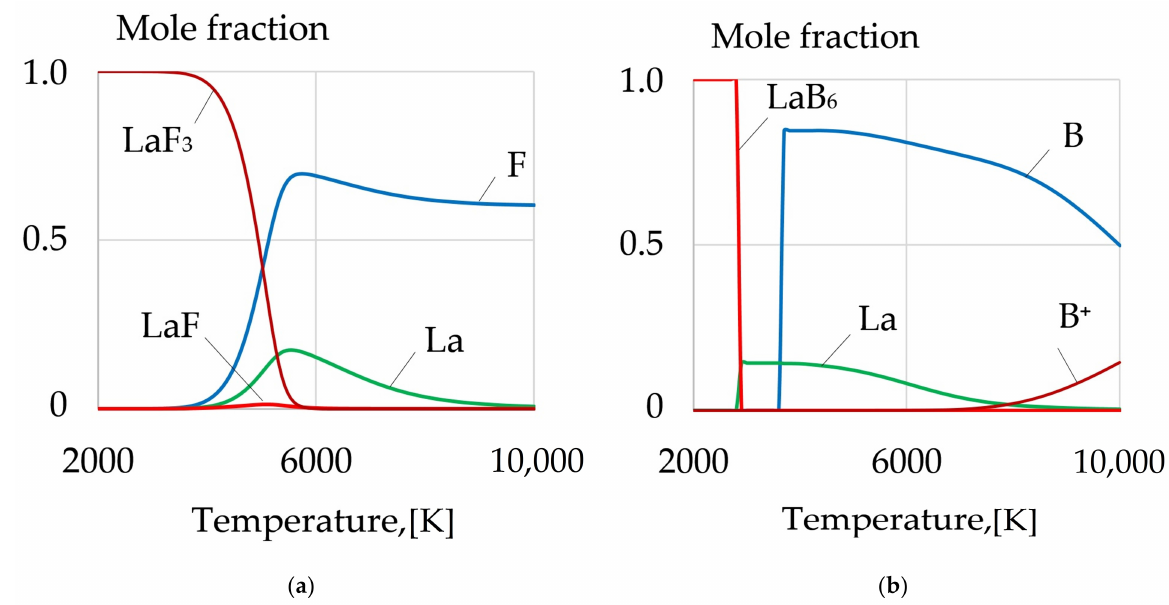
Figure 5. The mole fraction of components during dissociation: ( a ) LaF 3 ; ( b ) LaB 6 .